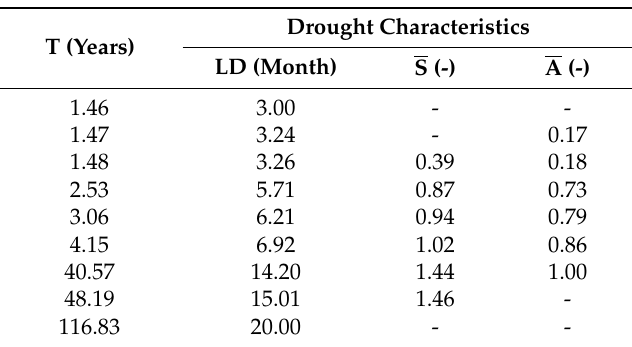
Table 6. Univariate drought return periods (T).